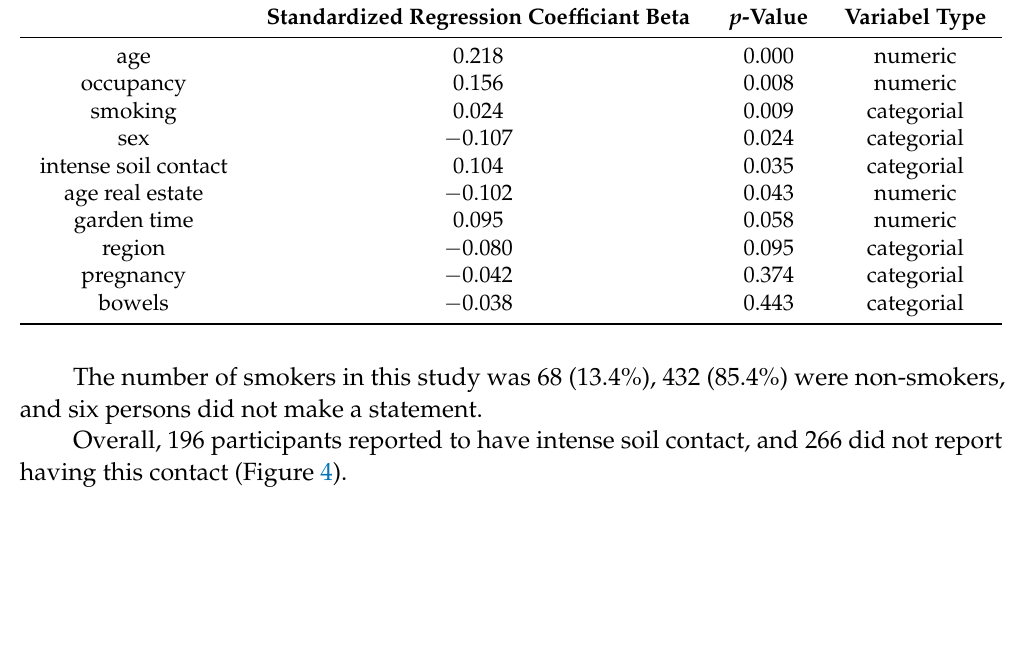
Table 2. Hierarchical regression analysis. Explanation of the BLL observed in the study population and significance.